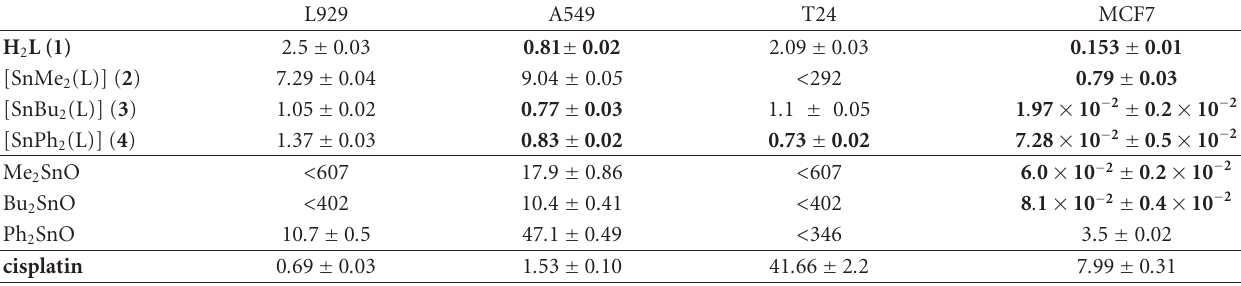
Table 4: The antiproliferative activity in vitro of 1–4, expressed as as IC 50 ± SD ( μ M) against MCF-7, T-24, A-549, and L-929 cancer cell